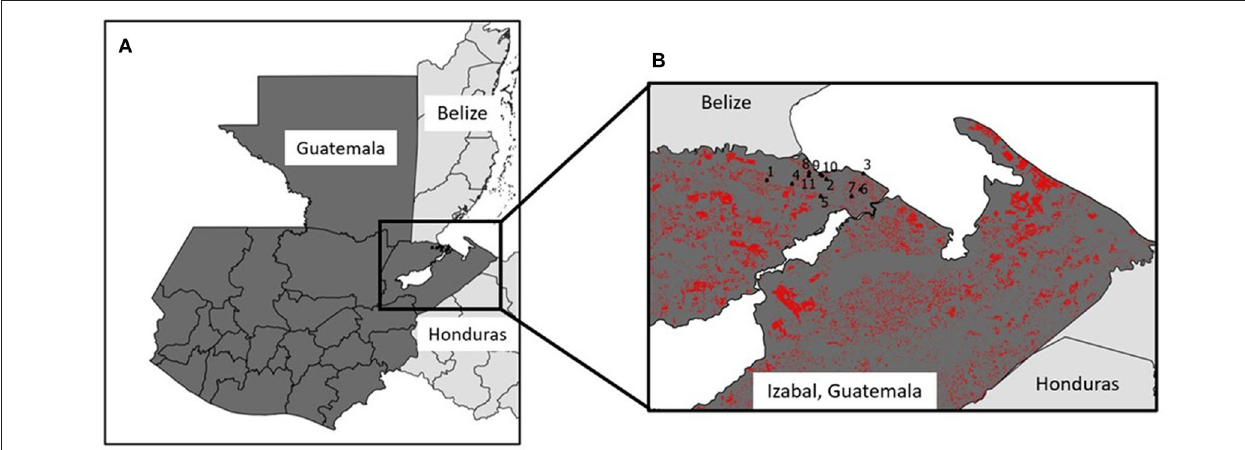
FIGURE 2 | Map of case study location and villages sampled in the Izabal Department of Guatemala. (A) Shows Guatemala alongside its neighboring countries of Belize and Honduras, both of which are adjacent to the study site shown in the inset map. (B) Shows a closer view of the eleven villages included in the case study, which are located in the Sarstún Region of Guatemala just south of the Sarstún River, which forms the border with Belize. Red pixels on the inset map represent forest loss from 2000–2014, the year that interviews were conducted. Source: